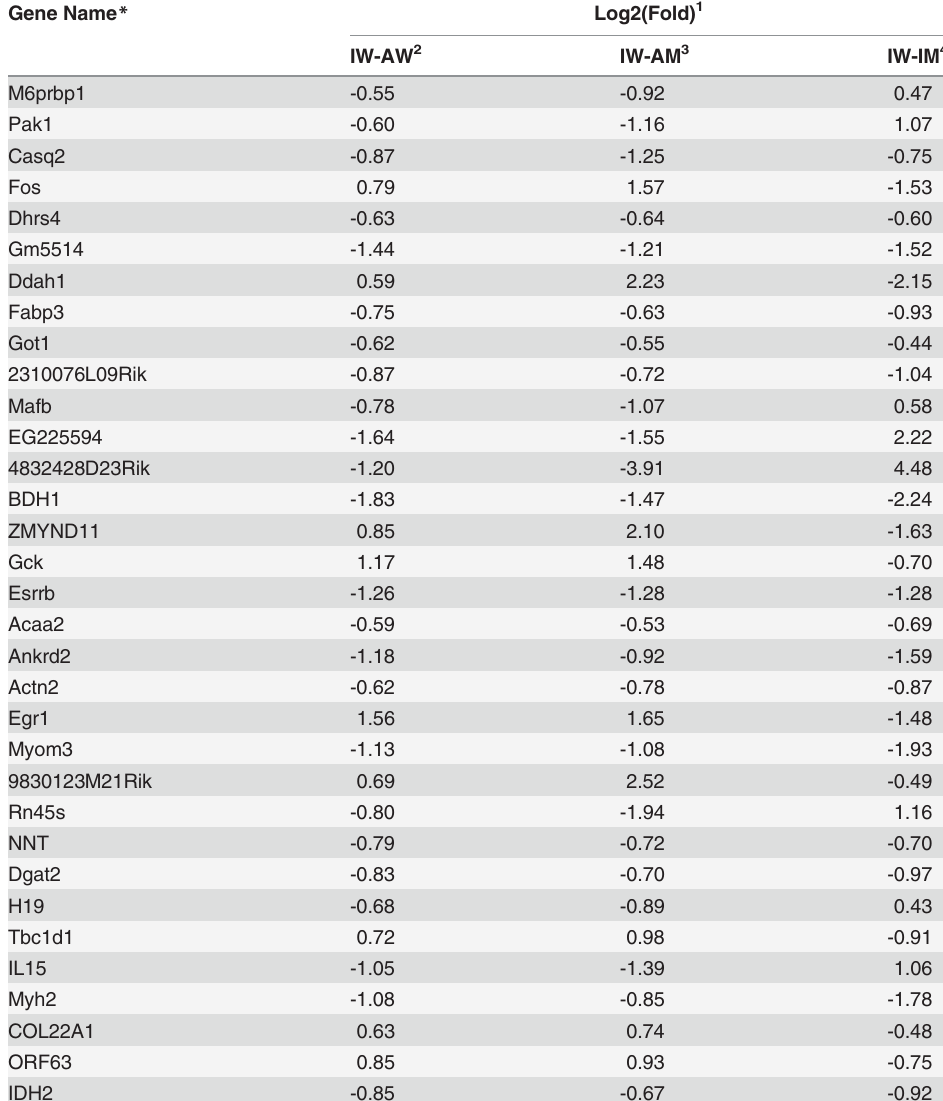
Table 2. Shared differentially expressed genes (FDR-adjusted P-value < .01) between three orthogonal contrasts including the Inactive-Wild Type (IW) baseline